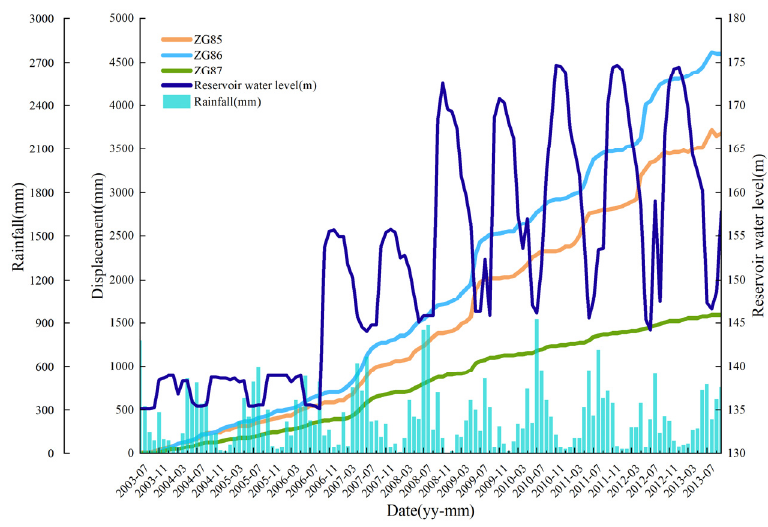
Figure 3. The correlation of the CD, rainfall and RWL with time.